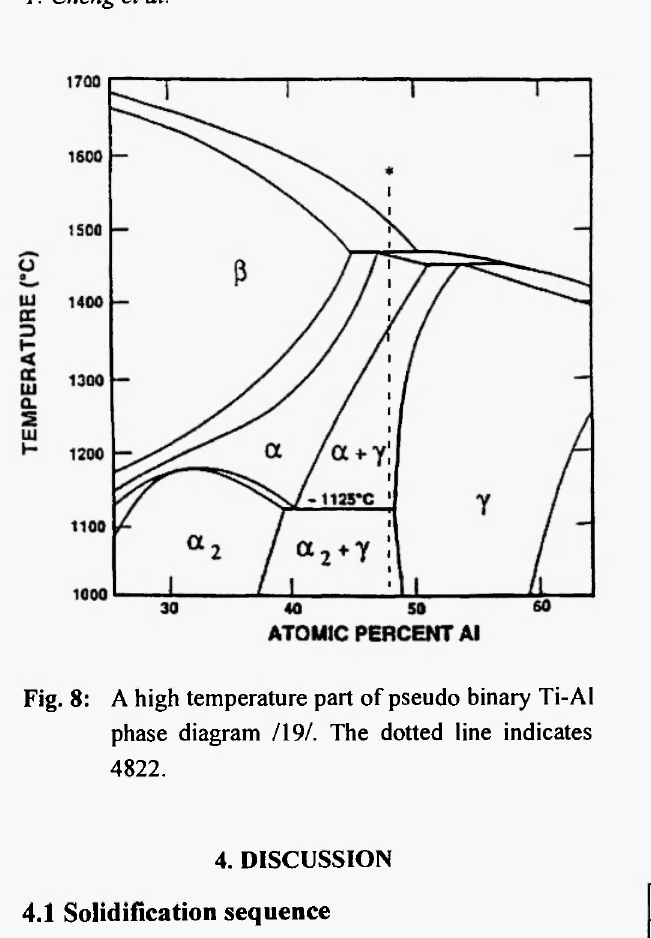
Fig. 8: A high temperature part of pseudo binary Ti-Al phase diagram /19/. The dotted line indicates